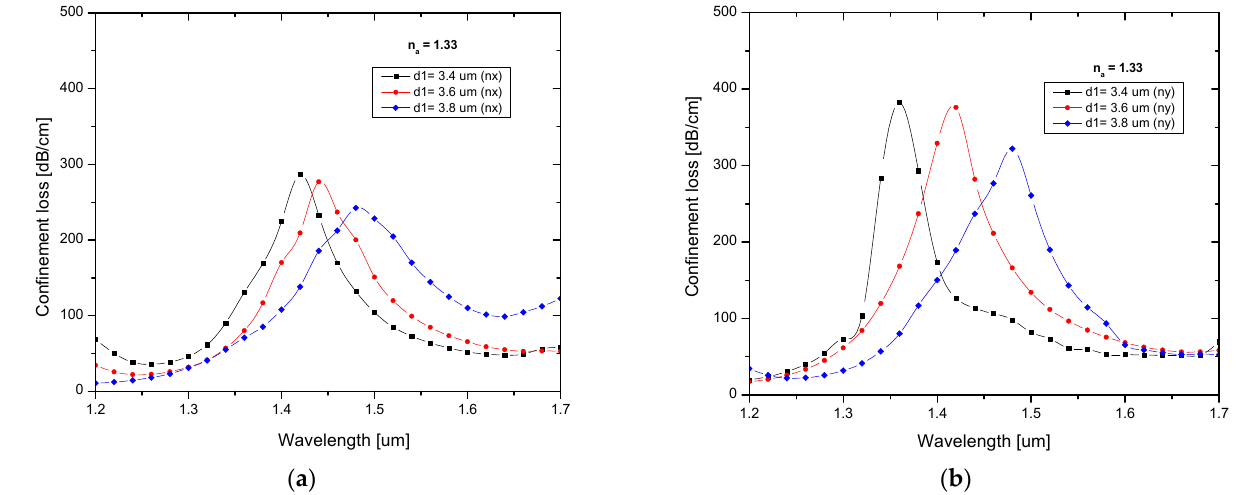
Figure 3. Confinement loss characteristics for different values of d1 for ( a ) X-polarization and ( b ) Y-polarization.